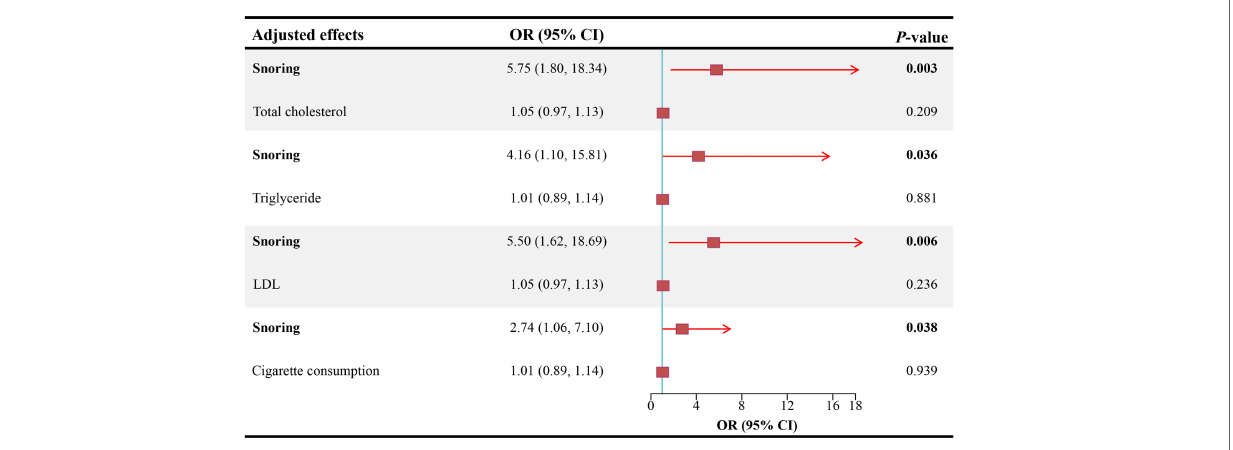
FIGURE 3 | Causal estimates of snoring on ED in MVMR. OR, odds ratio; CI, con fi dence interval; LDL, low-density lipoprotein; ED, erectile dysfunction; MVMR, multivariable mendelian